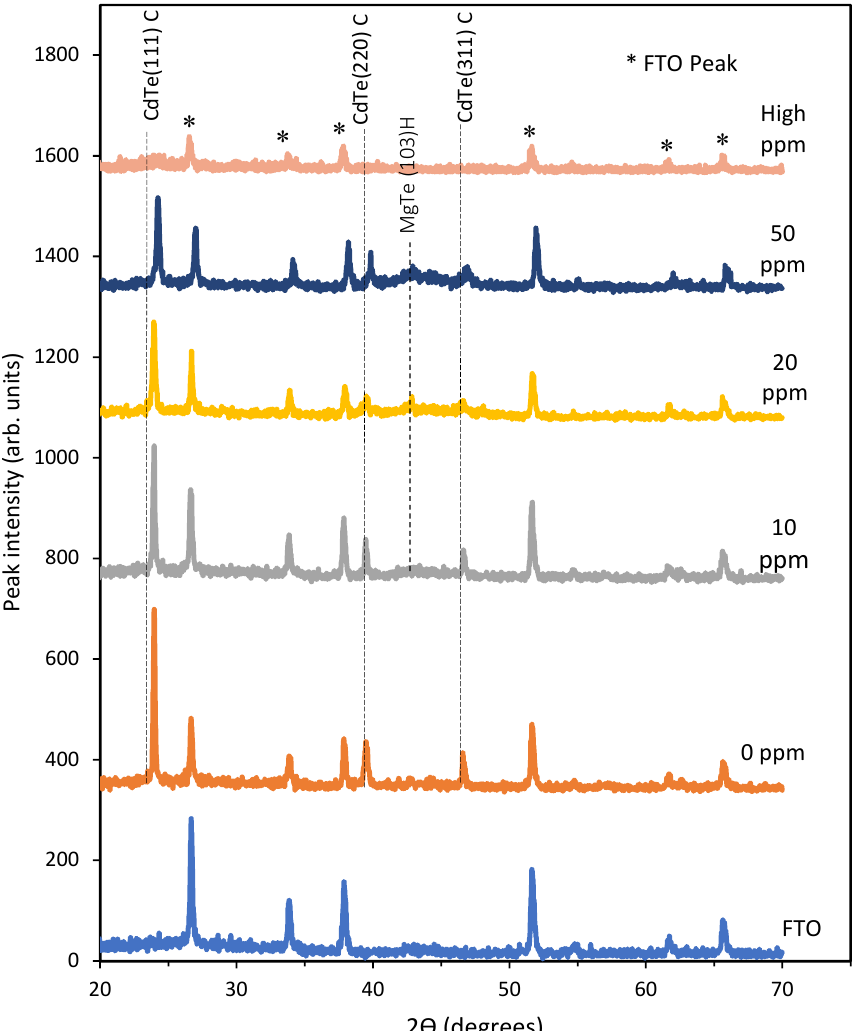
Figure 4. Decrement in XRD peak intensity with the increasing amount of Mg inclusion into the n-CdTe bath at ppm level.